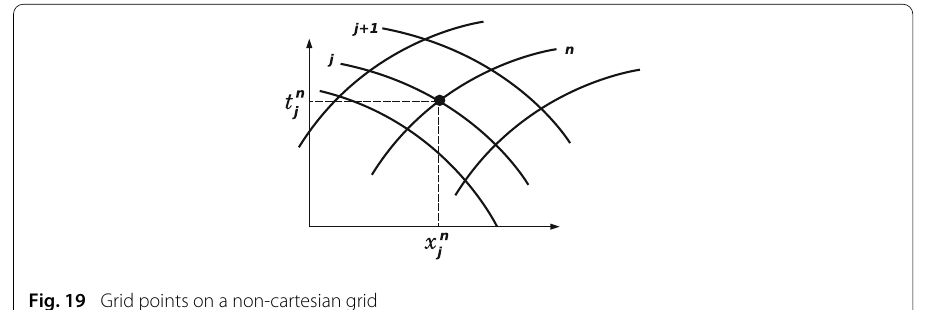
Fig. 19 Grid points on a non-cartesian